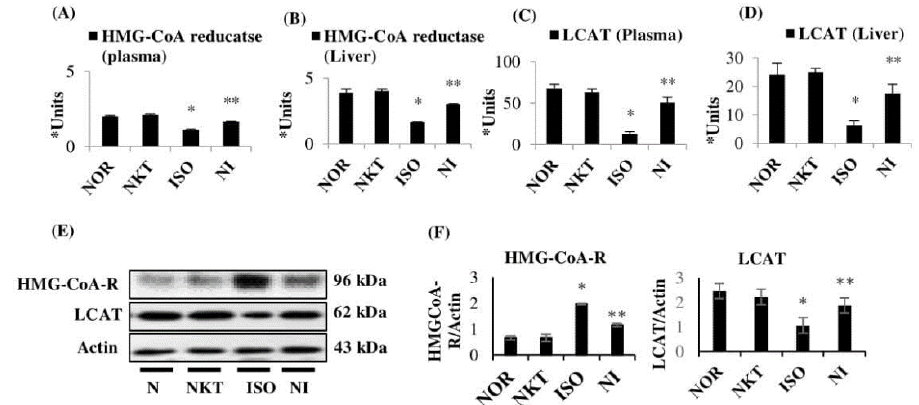
Figure 8. E ff ect of NKT of lipid marker enzymes in the plasma and liver: ( A , B ) activity of 3-hydroxy-3-methylglutaryl coenzyme-A reductase (HMG-CoA) reductase in the plasma and liver. Each column is the mean ± SEM for eight rats in each group; * p < 0.05 as compared to the normal control (Group-I), ** p < 0.05 as compared to the ISO control (Group-III) (DMRT). In group III, the lower ratio of HMG-CoA / mevalonate indicates higher enzyme activity and, in Group IV, a higher ratio of HMG-CoA / mevalonate indicates lower enzyme activity; ( C , D ) activity of lecithin cholesterol acyltransferase (LCAT) in the plasma and liver. Each column is the mean ± SEM for eight rats in each group; * p < 0.05 as compared to the normal control (Group-I), ** p < 0.05 as compared to the ISO control (Group-III) (DMRT). * Units: µ M of cholesterol esterified / h / mL for plasma LCAT and µ M of cholesterol esterified / h / mg protein for liver; ( E , F ) Western blotting analysis of HMG-CoA-R and LCAT in the liver and the densitometric analysis. Columns not sharing a common symbol (*, **) di ff er significantly from each other (* p < 0.05 vs. normal control, ** p < 0.05 vs. ISO control).